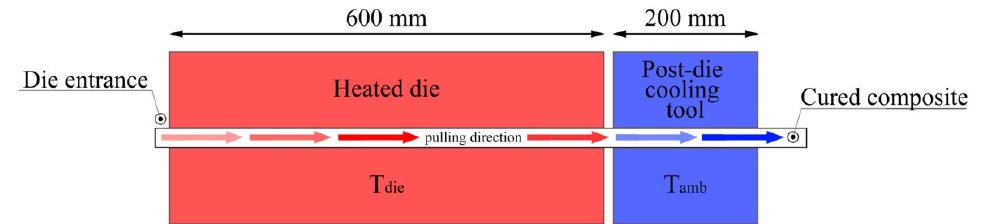
Figure 3. Geometry and position of the heated die and post-die cooling tool.